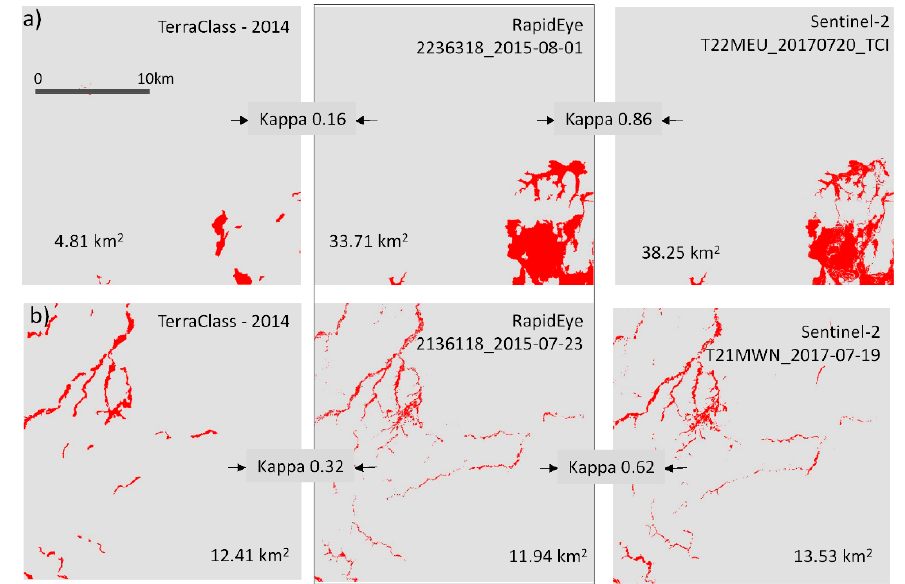
Figure 6. Comparison of mining areas between current available data (TerraClass 2014), map from RapidEye (taken as ground truth and limited to validation tiles, 25 × 25 km) and Sentinel-2A (mining maps for all study areas). In Carajás region ( a ), accuracy measured by Kappa index shows an improvement from 0.16 (TC2014) to 0.86 (S2A), due to a large omission error in TC2014. For small-scale mining in Tapaj ó s ( b ), Kappa increased from 0.32 to 0.62. S2A classification were able to detect small polygons, whereas TC2014, due to a coarser classification, lacks